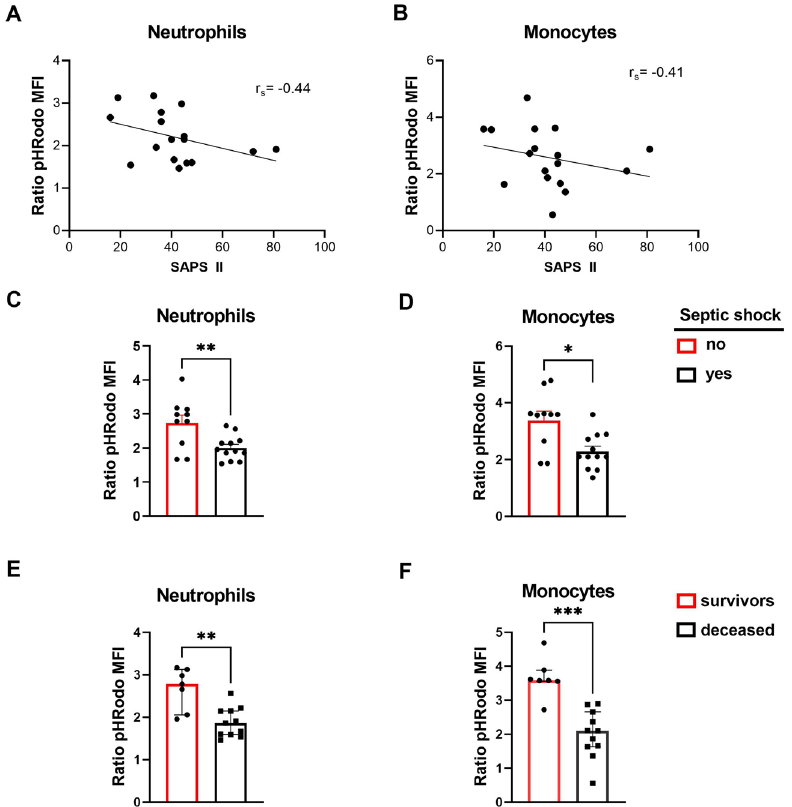
Figure 5. Functional impairment of phagocytes is linked to organ dysfunction, septic shock, and mortality in ICU patients. ( A , B ) Correlation between phagocytosis and SAPS II in ( A ) neutrophils and ( B ) monocytes. Rs Spearman correlation coefficient Rho. ( C , D ) Phagocytosis capacity in patients with (black) or without (red) a septic shock of ( C ) neutrophils and ( D ) monocytes. The histograms represent the median and the error bars the interquartile range . Intergroup comparison by Mann–Whitney U test , **P < 0.01, *P < 0.05. (E–F) Phagocytosis capacity in survivors (red) and deceased (black) ICU patients of ( E ) neutrophils and ( F ) monocytes. Intergroup comparison by Mann–Whitney U, ***P < 0.001, **P <